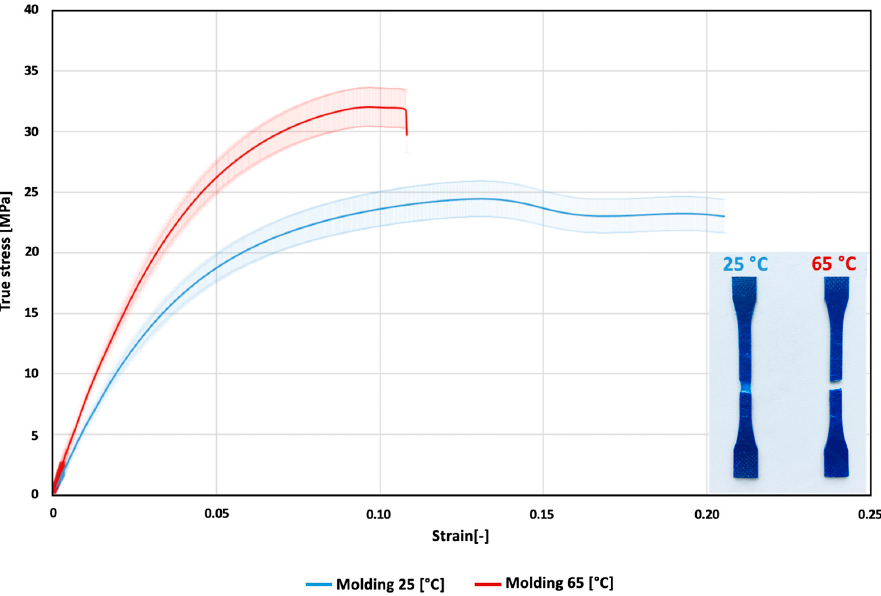
Figure 6. Tensile curves of the average values together with standard deviations for the 25 °C and 65 °C samples. 65 ◦ C